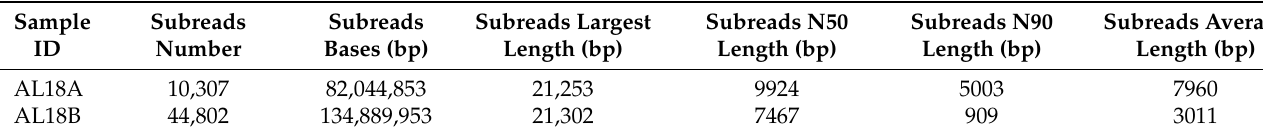
Table 2. PacBio sequencing data statistics of AL18A and AL18B.